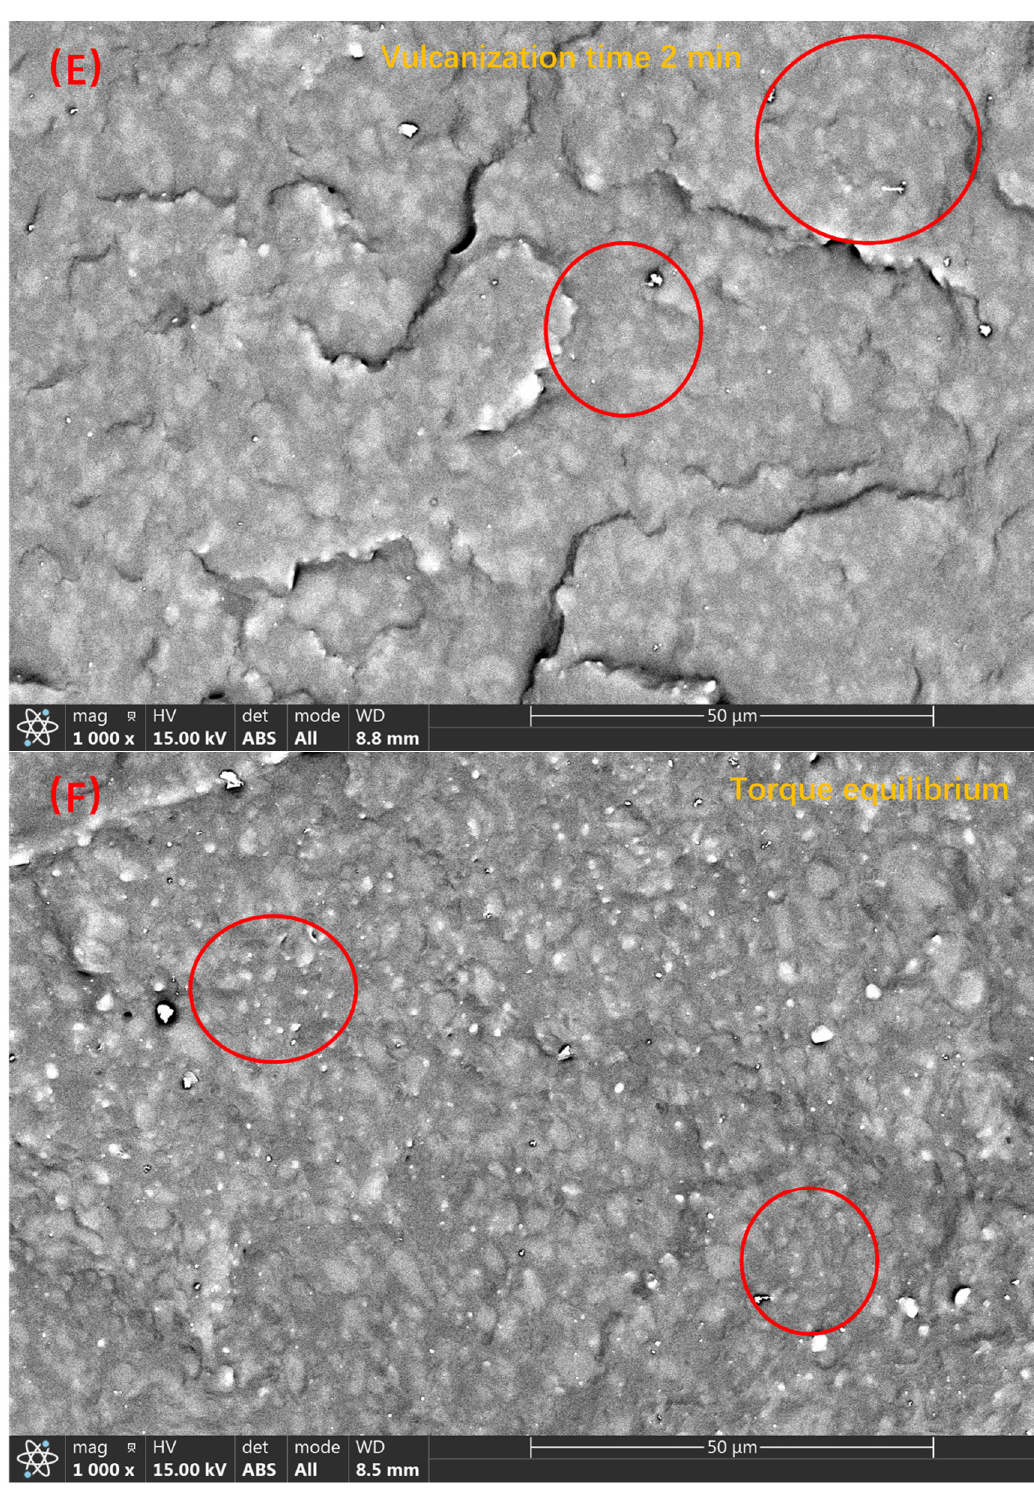
Figure 6. The backscattering image of sample 3 during the vulcanization process (( A – E ) correspond to the vulcanization times of 0 min, 0.5 min, 1 min, 1.5 min, and 2 min, respectively, and ( F ) is the backscattered image after torque equilibrium. The change in the particle size of PSR as the vulcanization process proceeds is marked by the circles in the figure.).